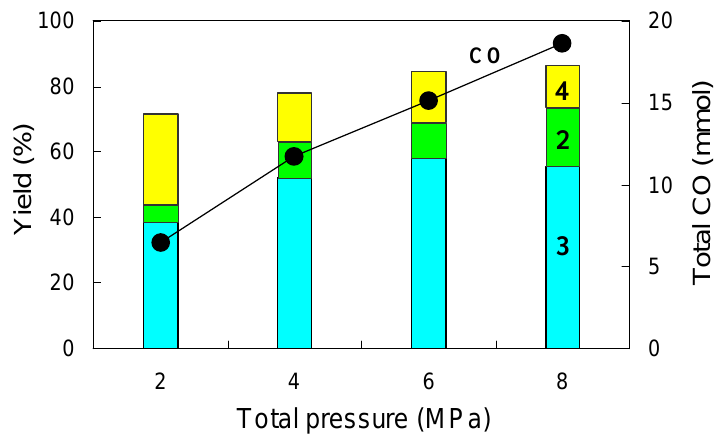
and H (1:1) on the reactions under conditions: catalyst 2 2